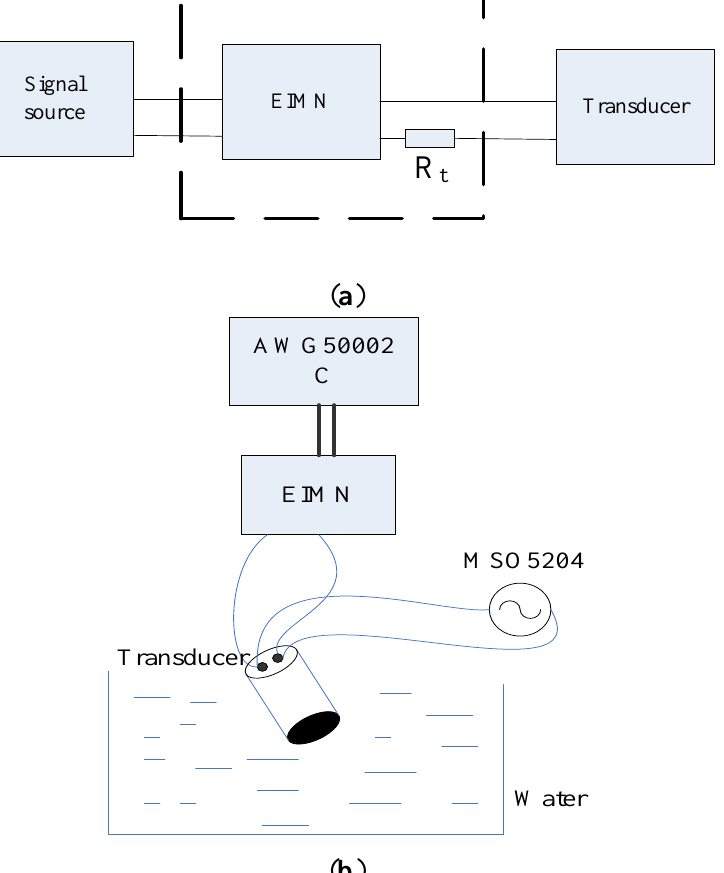
Figure 19. ( a ) A schematic block diagram for the experiment ( b ) the experimental setup.